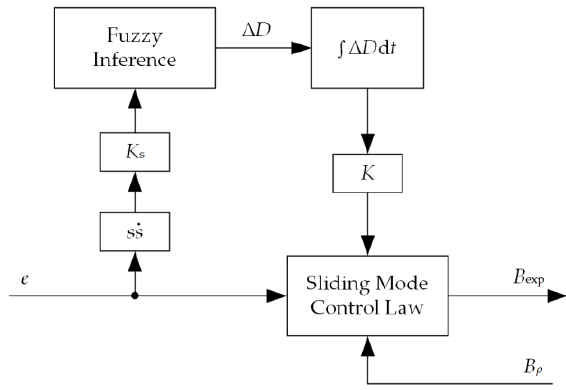
Figure 8. Block diagram of fuzzy sliding mode depth controller.